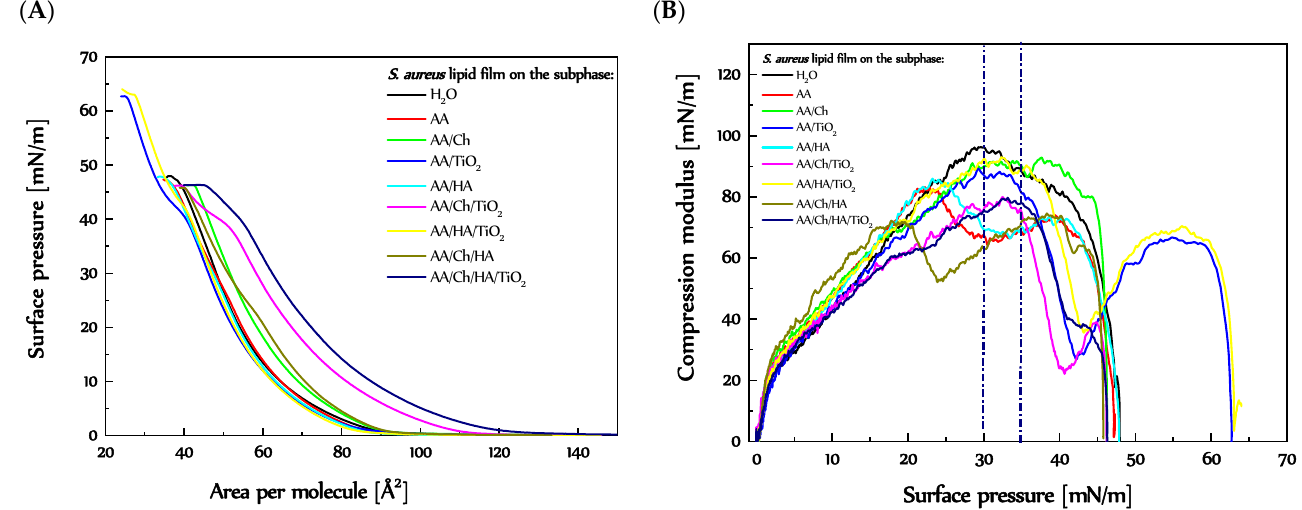
Figure 4. ( A ) π -A isotherms obtained by means of the Langmuir technique and determined based on them ( B ) C S − 1 = f( π ) relationships for S. aureus lipid monolayers on the individual subphases (more details Figure